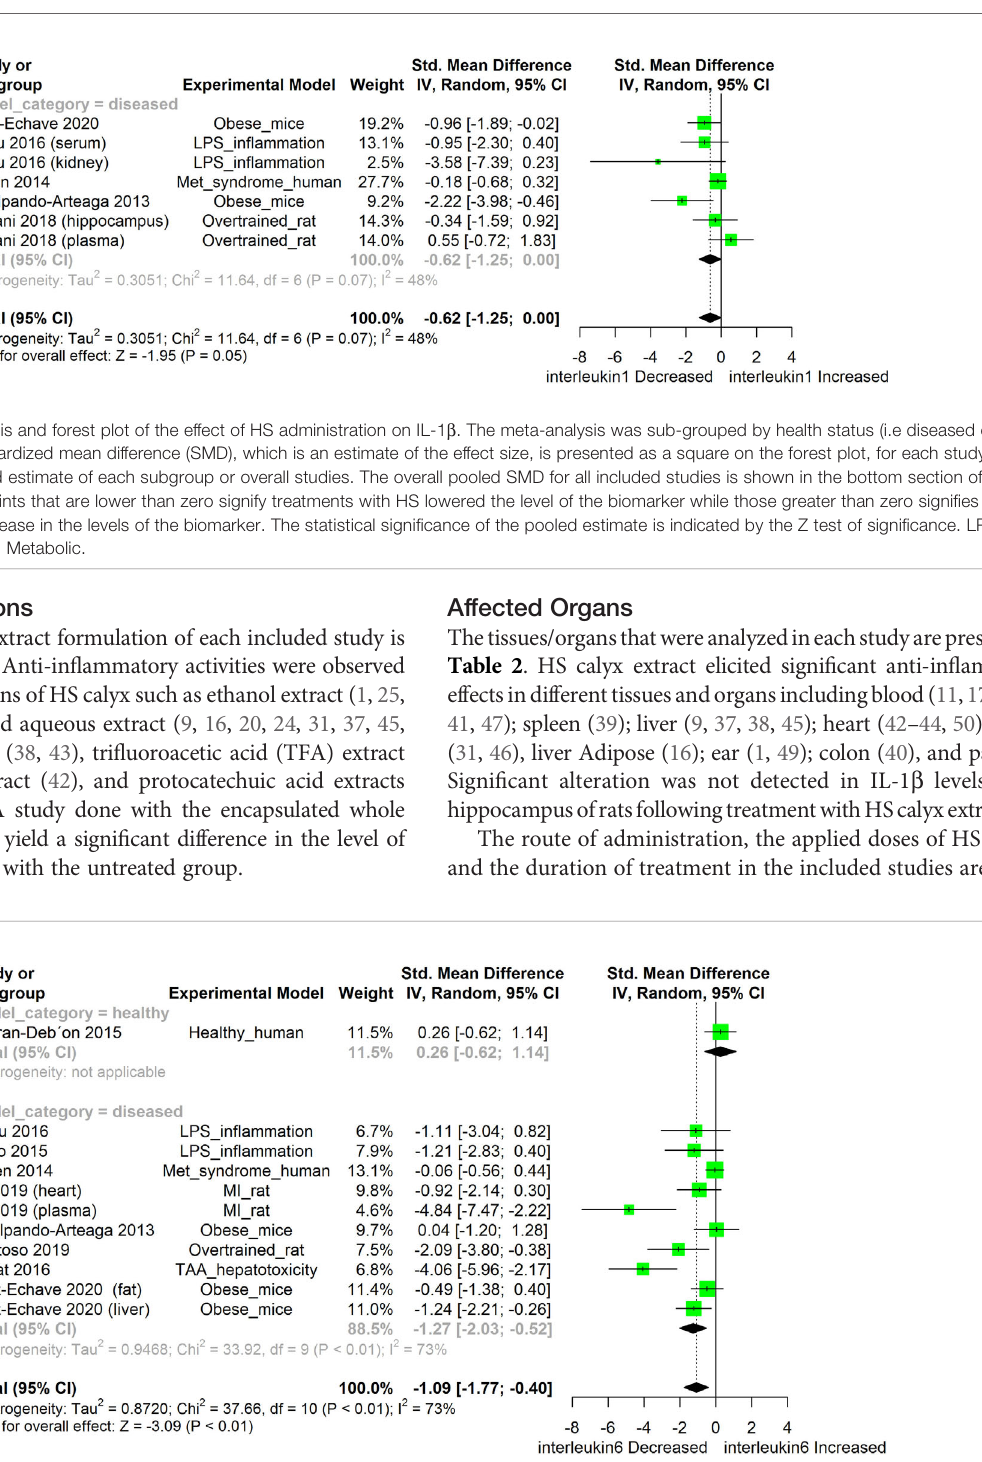
FIGURE 6 | Meta-analysis and forest plot of the effect of HS administration on IL-6. The meta-analysis was sub-grouped by health status (i.e diseased or healthy state). The standardized mean difference (SMD) which is an estimate of the effect size, is presented as a square on the forest plot, for each study and as a diamond for the pooled estimate of each subgroup or overall studies. The overall pooled SMD for all included studies is shown in the bottom section of the forest plot. SMD data points that are lower than zero signify that treatments with HS lowered the level of the biomarker while those greater than zero signify that HS treatment caused an increase in the levels of the biomarker. The statistical signi fi cance of the pooled estimate is indicated by the Z test of signi fi cance. LPS, Lipopolysaccharide; Met, Metabolic; TAA, Thioacetamide; MI, Myocardiac